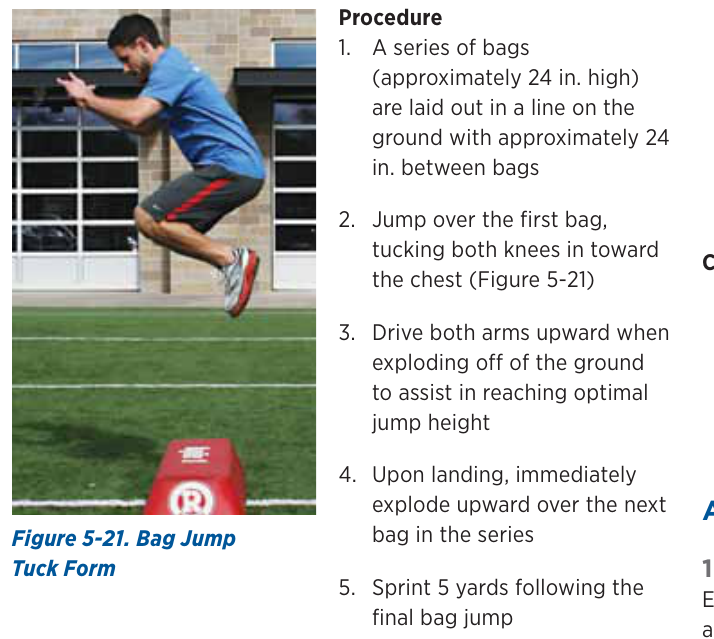
Figure 5-21. Bag Jump